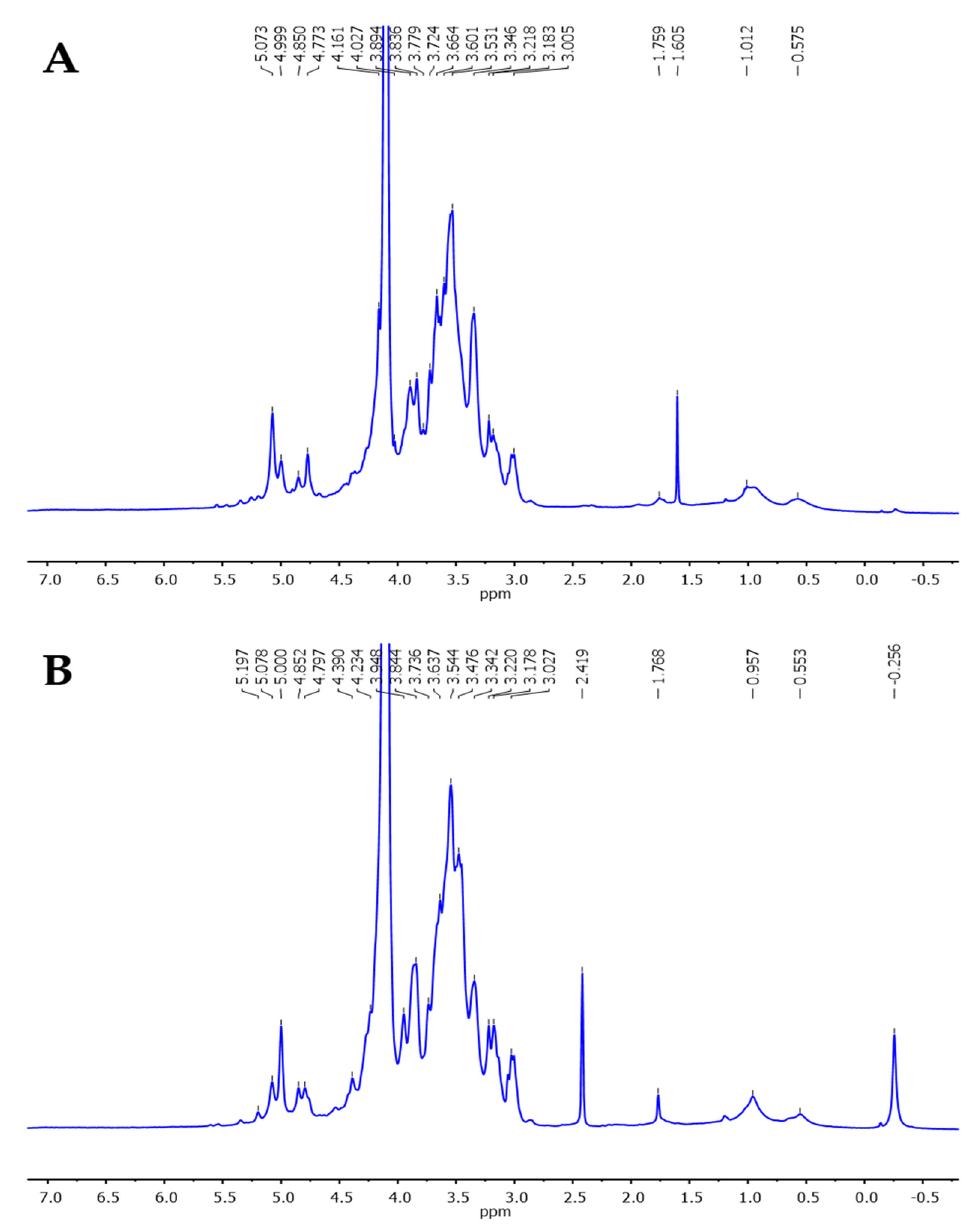
Figure 2. 1 H-NMR spectra of ( A ) JSP and ( B ) JDP fractions. The analyses were recorded at 60 °C for samples in D 2 O solution (40 g/L).